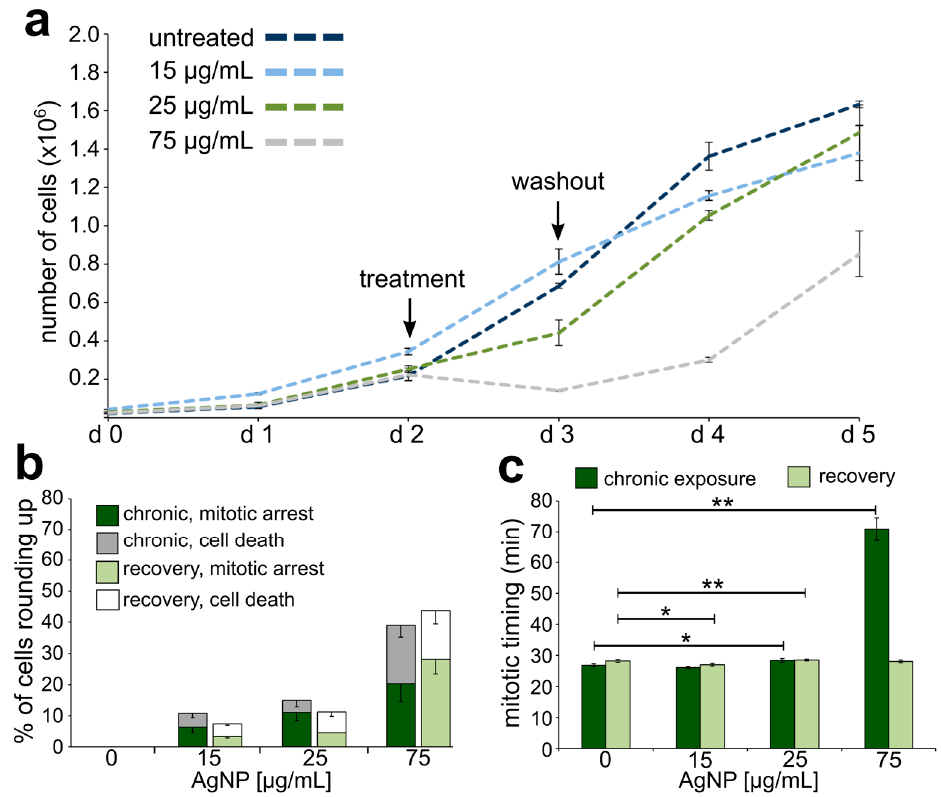
Figure 6. Effects on cell division and cell proliferation from chronic AgNP exposure and recovery. (a) Proliferation rates for cells exposed to a chronic treatment regime with increasing concentrations of AgNPs. (b) Percentage of cells observed to either arrest or die. The data corresponding to events observed during the last of 12 treatments are shown in darker colors (dark green and grey), whereas the data corresponding to events observed during recovery from the last treatment are shown in lighter colors (light green and white). (c) Mitotic timing in cells completing mitosis during the last treatment of a chronic AgNP exposure (dark green bars) or recovering from the last treatment of a chronic AgNP exposure (light green bars). * t-test, p < 0.05, ** t-test, p < 0.005.